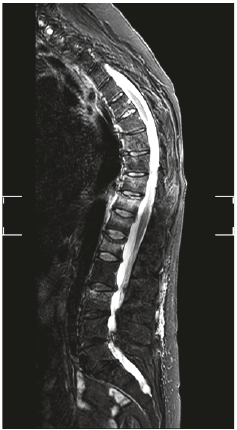
Figure 1: Preoperative sagittal magnetic resonance image (STIR sequence) of the lumbar spine showing edema of multiple vertebral